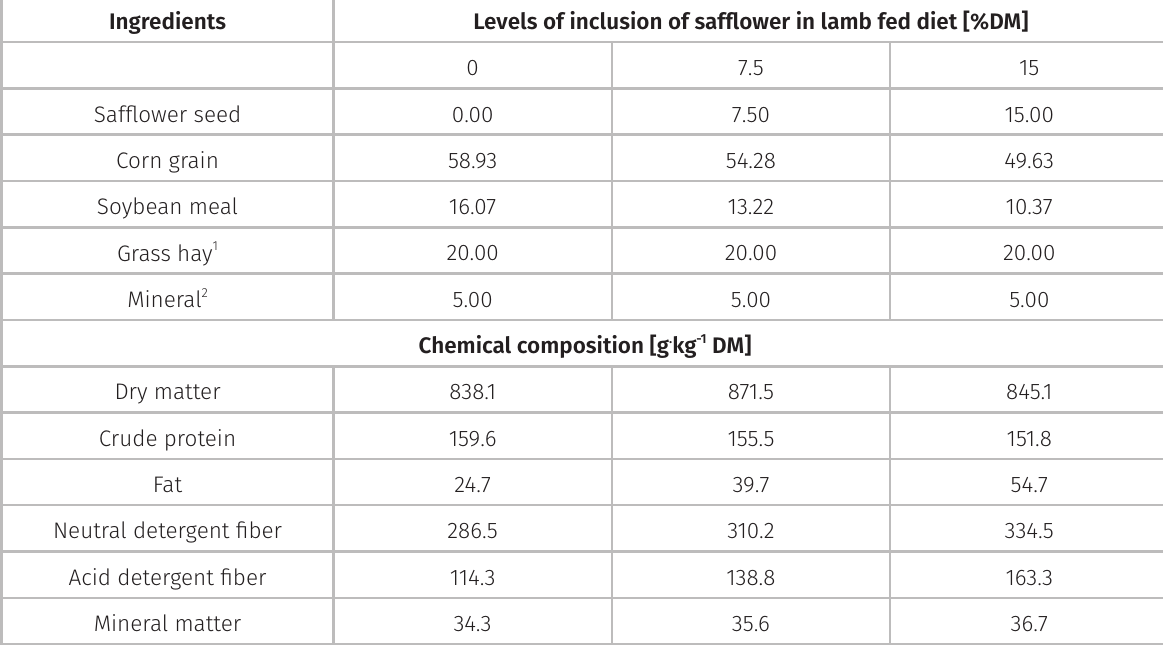
Table I. Proportion of ingredients and chemical composition of lambs fed diet in the confinement period.